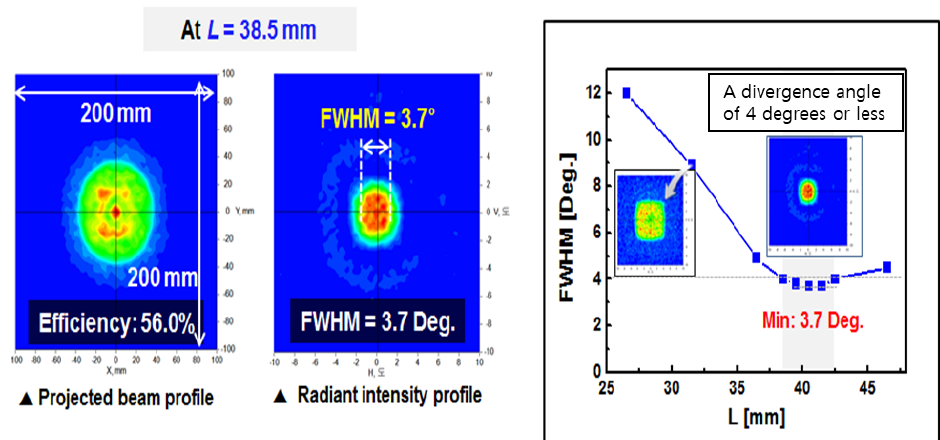
Figure 15. Laser module optical system divergence characteristics by distance.